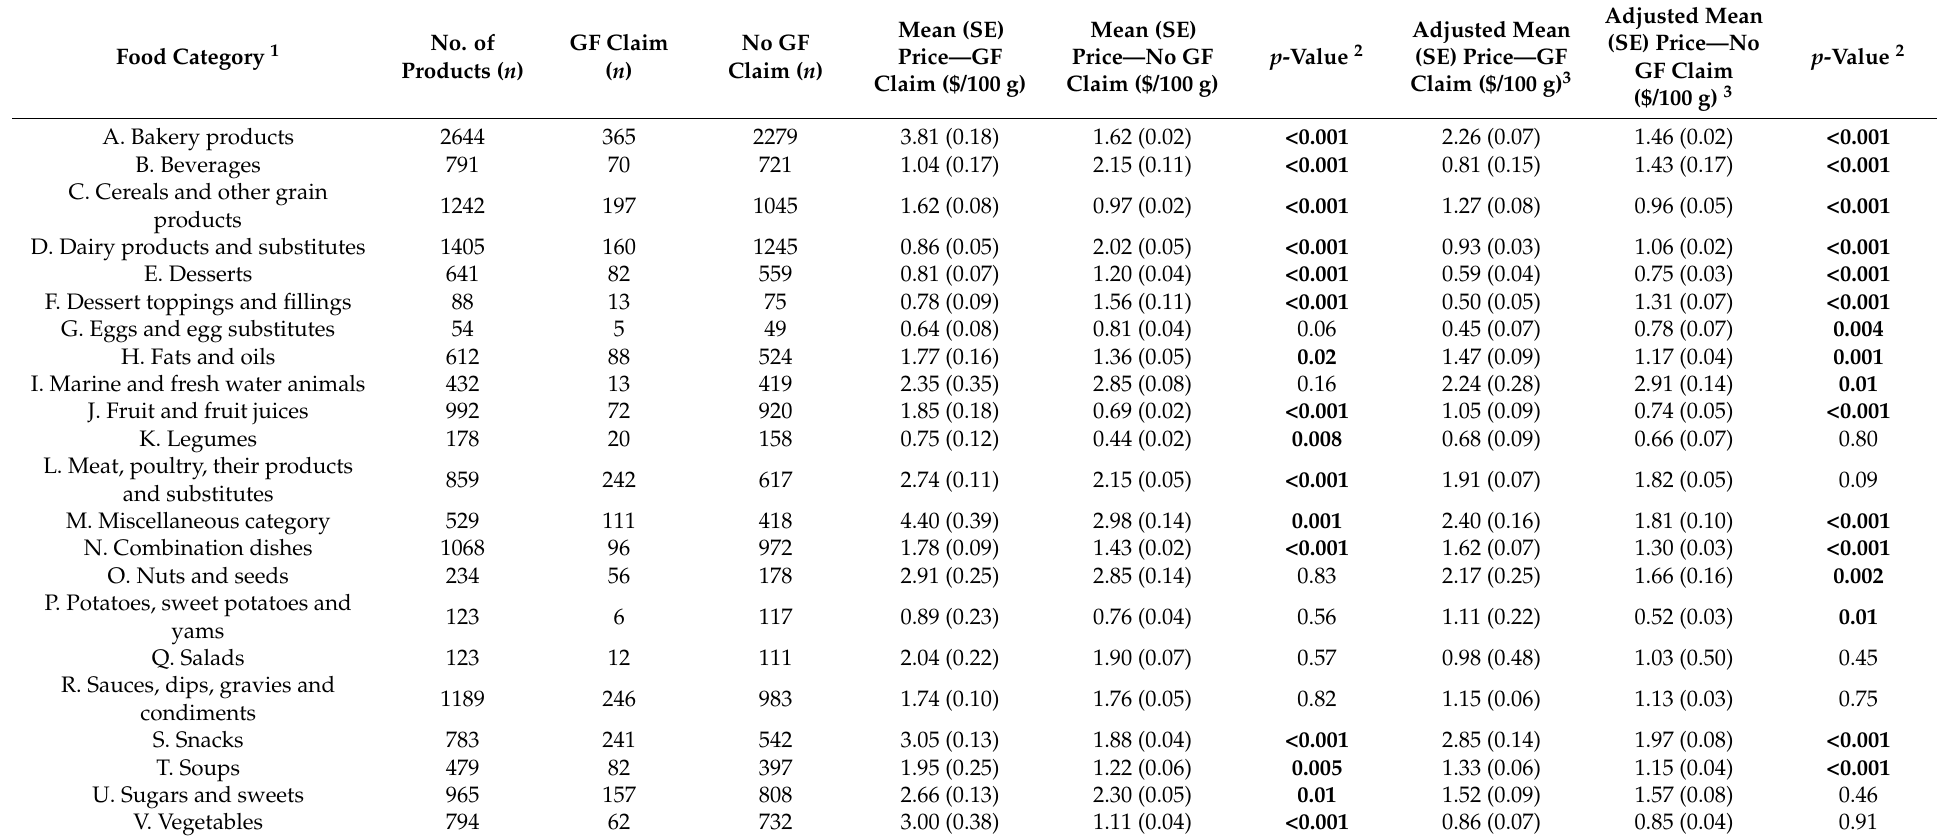
Table 4. The mean price per 100 g (or mL) of products with and without gluten-free (GF) claims in